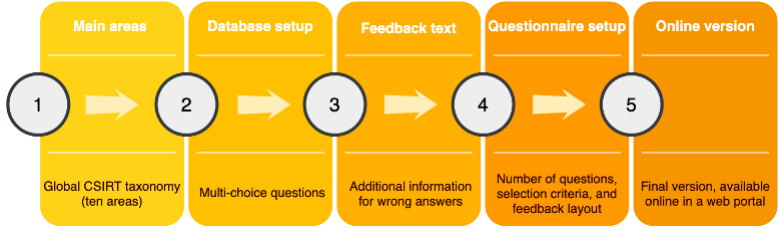
Figure 3. Methodology adopted to develop the web application for self-diagnosis.